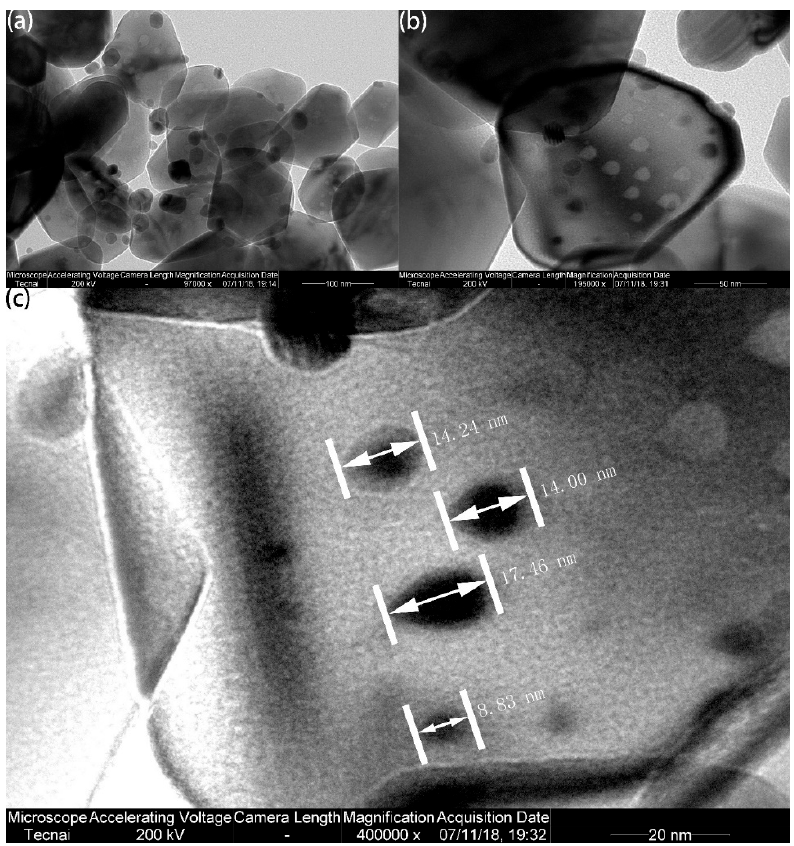
Figure 7. TEM images of Ag/ZnO (100:1), ( a ) 100 nm, ( b ) 50 nm, ( c ) 20 nm.